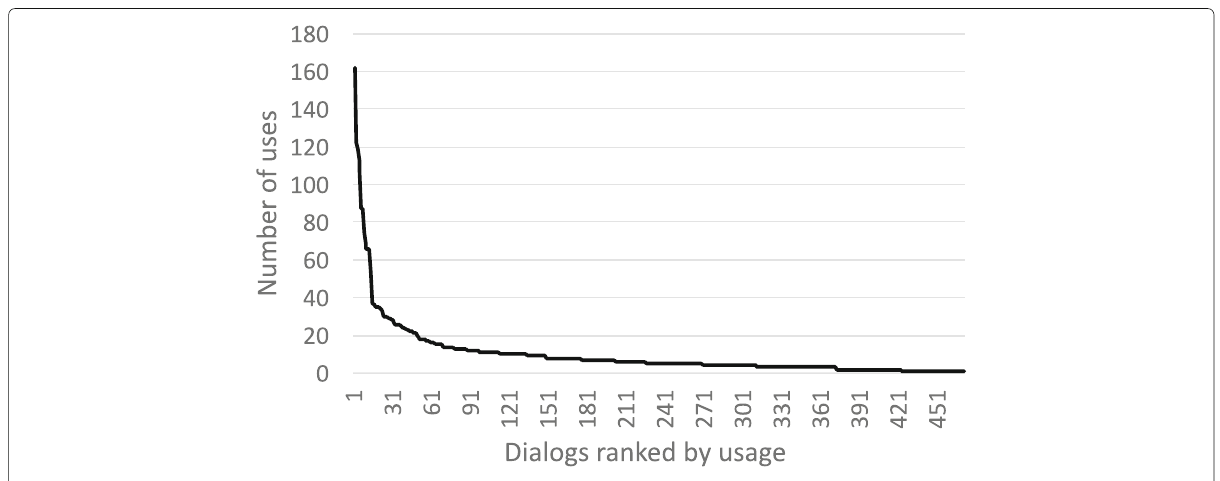
Fig. 15 Usage of spoken dialog provided by